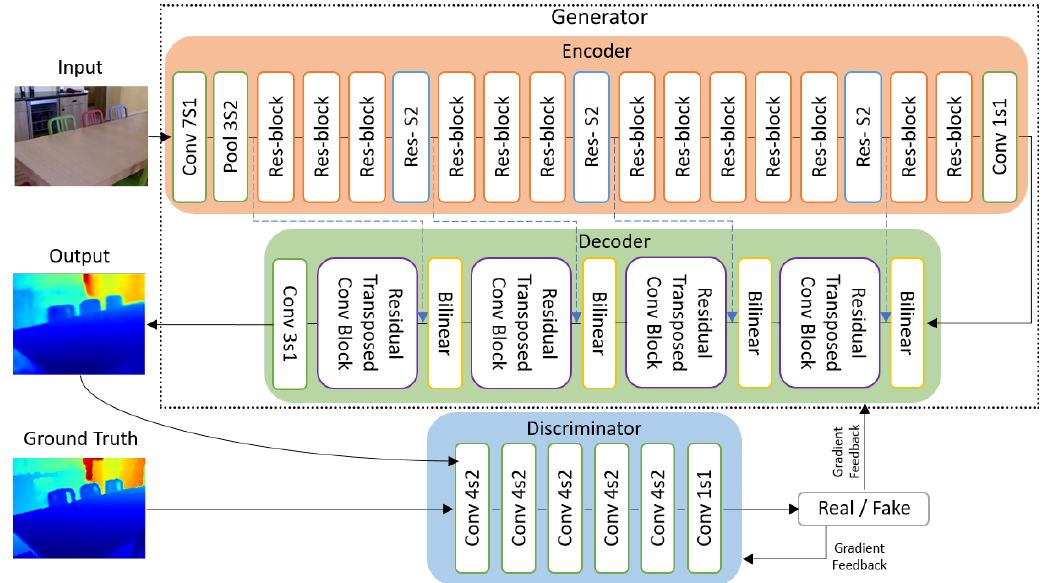
Figure 2. This figure shows a diagram of our proposed network architecture. The details of the residual transposed convolution block is discussed in Section 3.2.2 and further illustrated in Figure